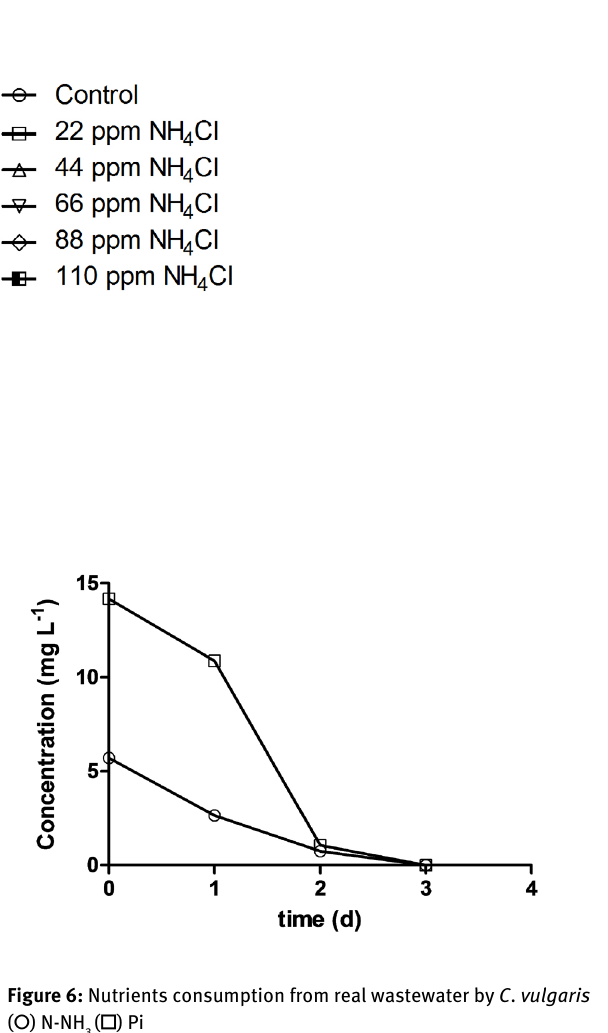
Figure 6: Nutrients consumption from real wastewater by C . vulgaris (○) N-NH (□) 3